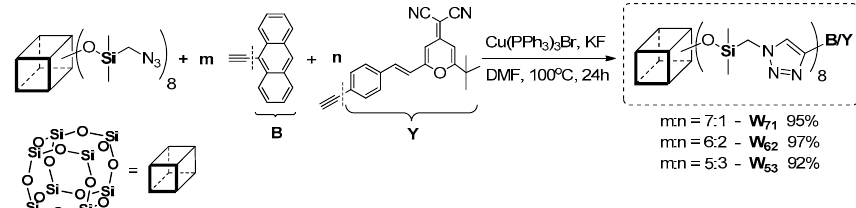
Figure 37. Synthetic route to octa(azidomethylene)spherosilicate derivatives obtained by a 1,3-dipolar Huisgen reaction.